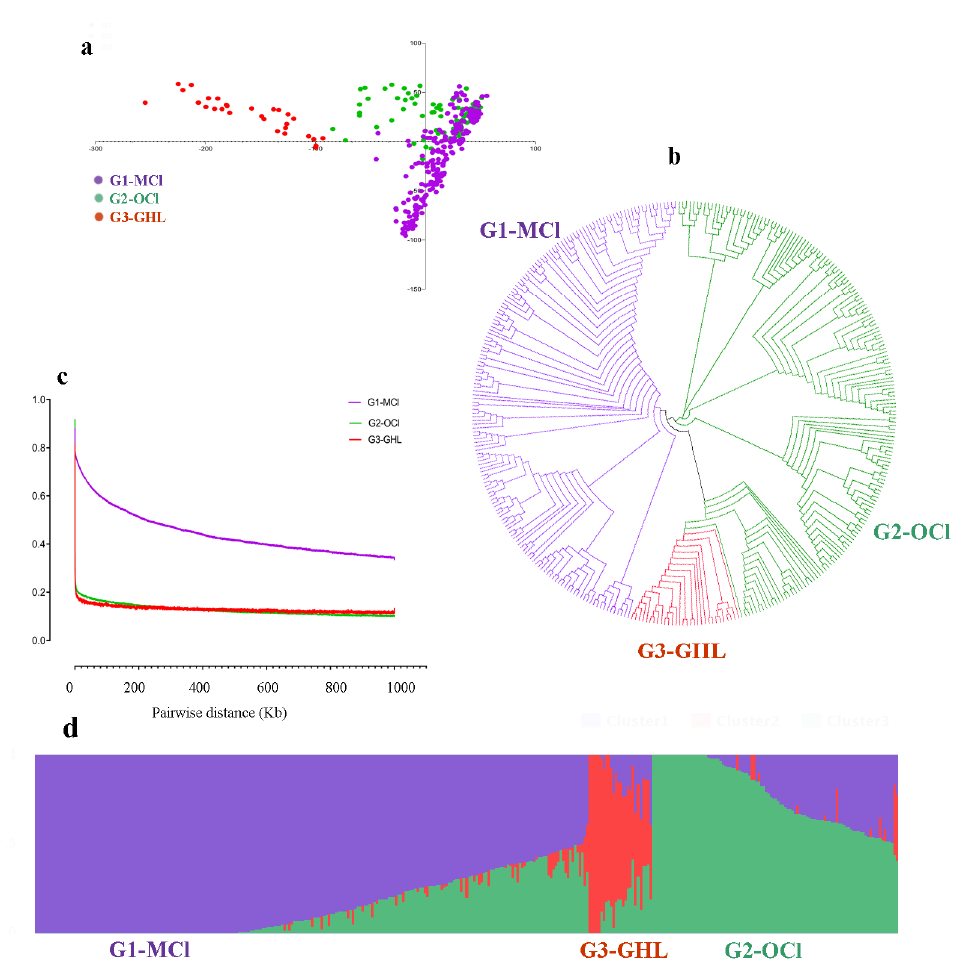
Figure 1. Population stratification. ( a ) Principal component analysis (PCA) plot of the first two PCAs, i.e., PCA1 (21.898%) and PCA2 (2.988%), for all accessions. Dot colour scheme is as G1-MCl = Modern cultivars G2-OCl = Obsolete Cultivars collected from south china, G3-GHL = Geographical landraces of G. hirsutum, ( b ) Phylogenetic tree constructed using whole-genome data, distributing genotypes into three clades as per original classification, ( c ) Pairwise linkage disequilibrium (LD) decay in each group, ( d ) Structure results for